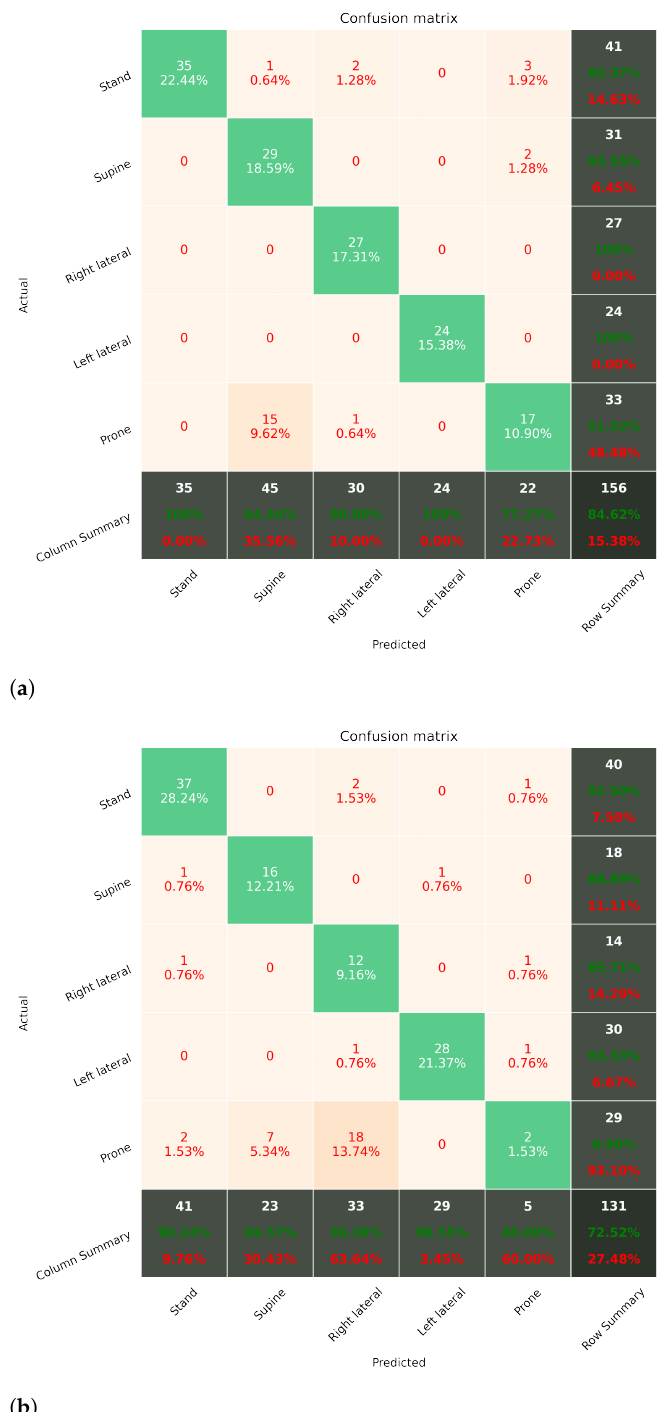
Figure 11. The prediction accuracy of adopting RF as the learning algorithm. ( a , b ) show the confusion matrices of the prediction results of S1 and S2. The overall accuracy of the subjects are 0.84 and 0.72, respectively. ( a ) RF with subject 1; ( b ) RF with subject